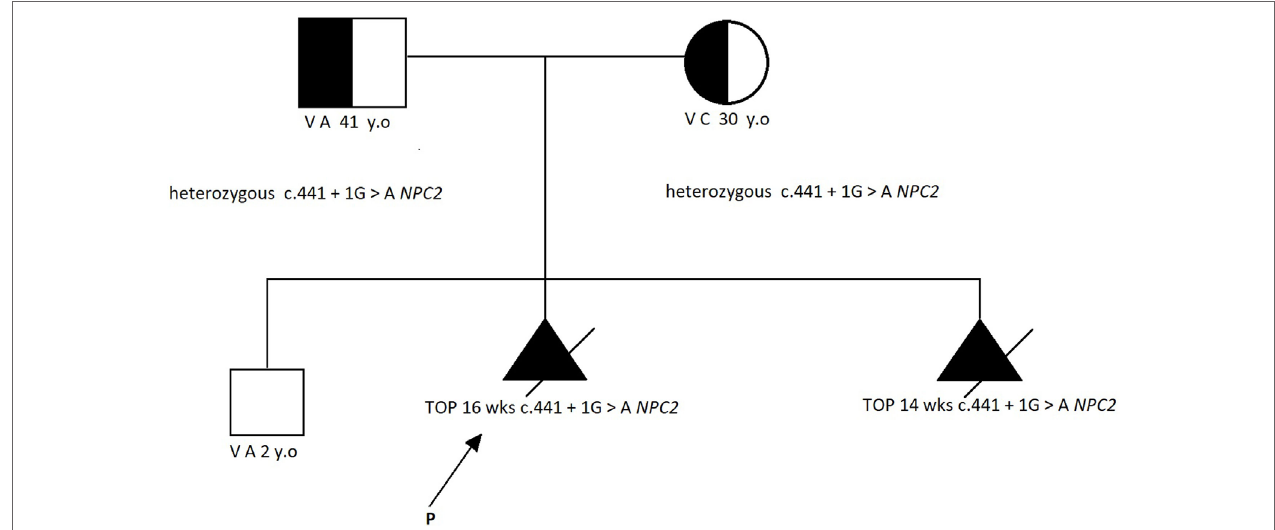
FIgURe 2 | The family pedigree [according to Ref.